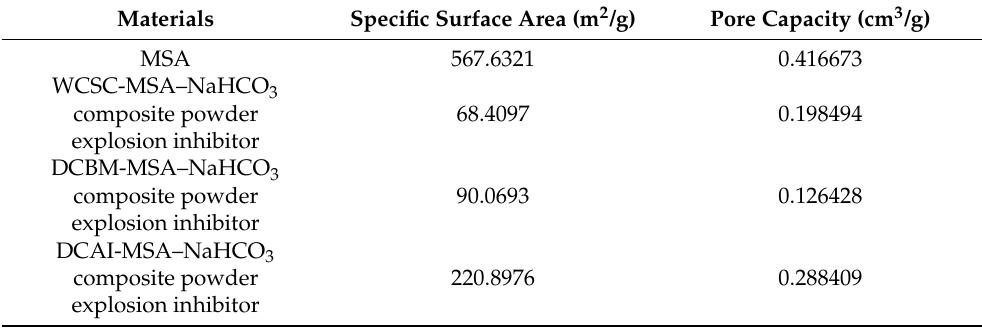
Figure 4. SEM images of MSA–NaHCO 3 composite powder explosion inhibitors prepared with three preparation methods: ( a ). NaHCO 3 ; ( b ). MSA; ( c ). WCSC-MSA–NaHCO 3 ; ( d ). DCBM-MSA– NaHCO 3 ; ( e ). DCAI-MSA–NaHCO 3 . Table 3. Analysis of specific surface area and pore volume of composite powder explosion